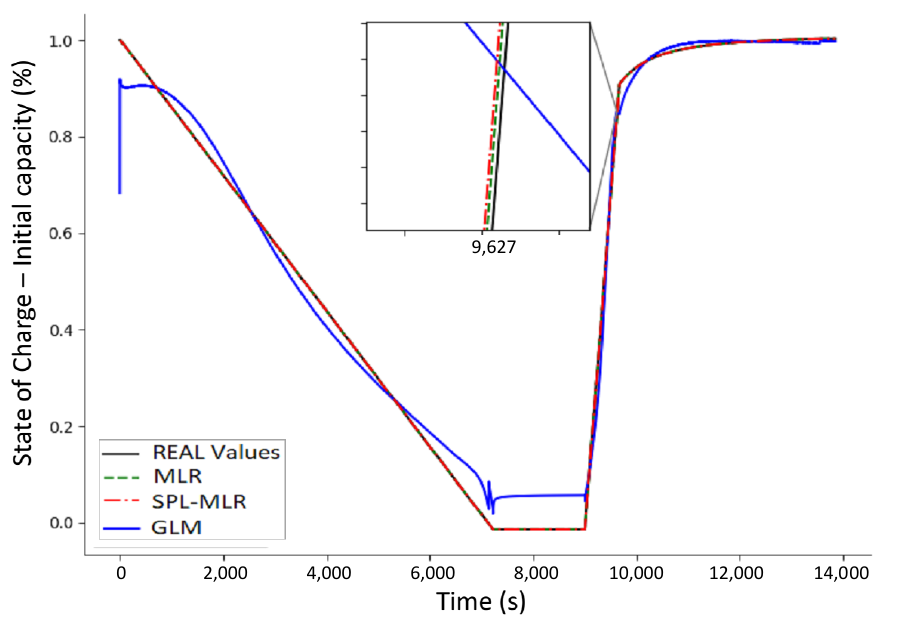
Figure 6. Initial Capacity Curve for PSO